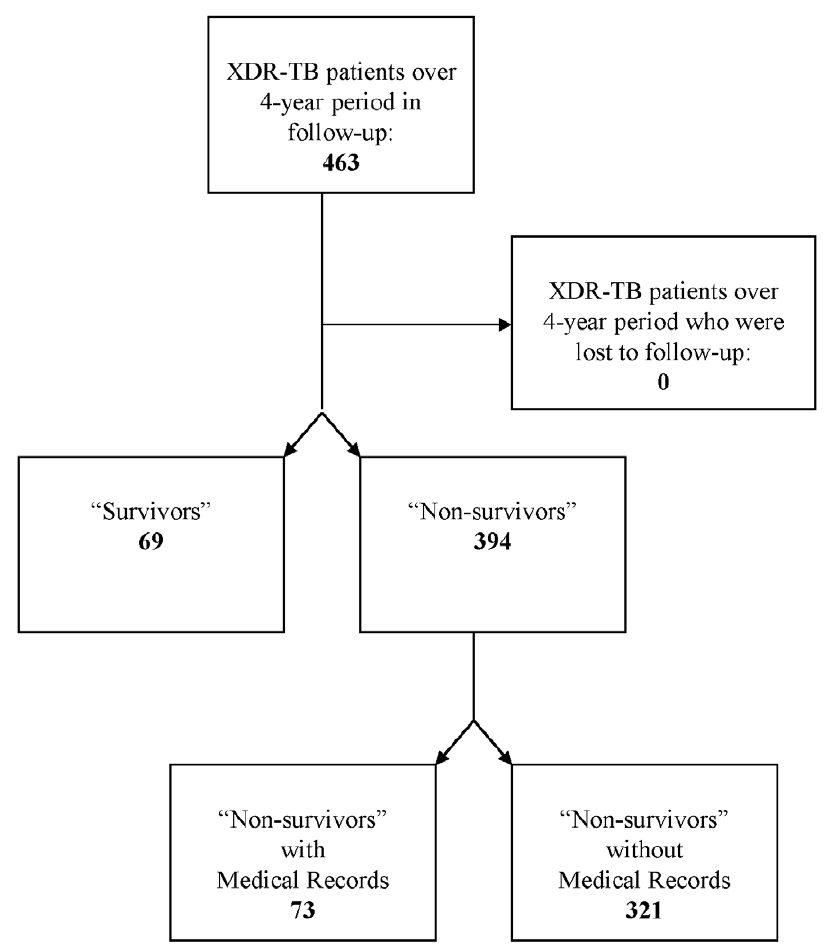
Figure 1. Selection of Charts for Review.